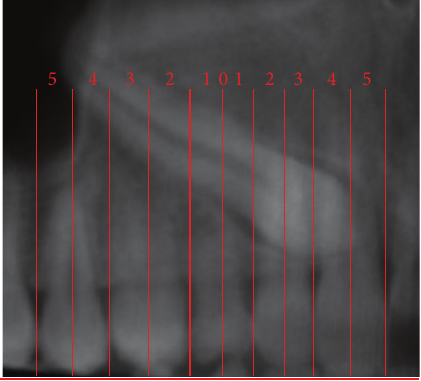
Figure 2: Vertical position (𝑦) for cusp tip; Panorex view. In this example 𝐶 𝑦 = 2 .